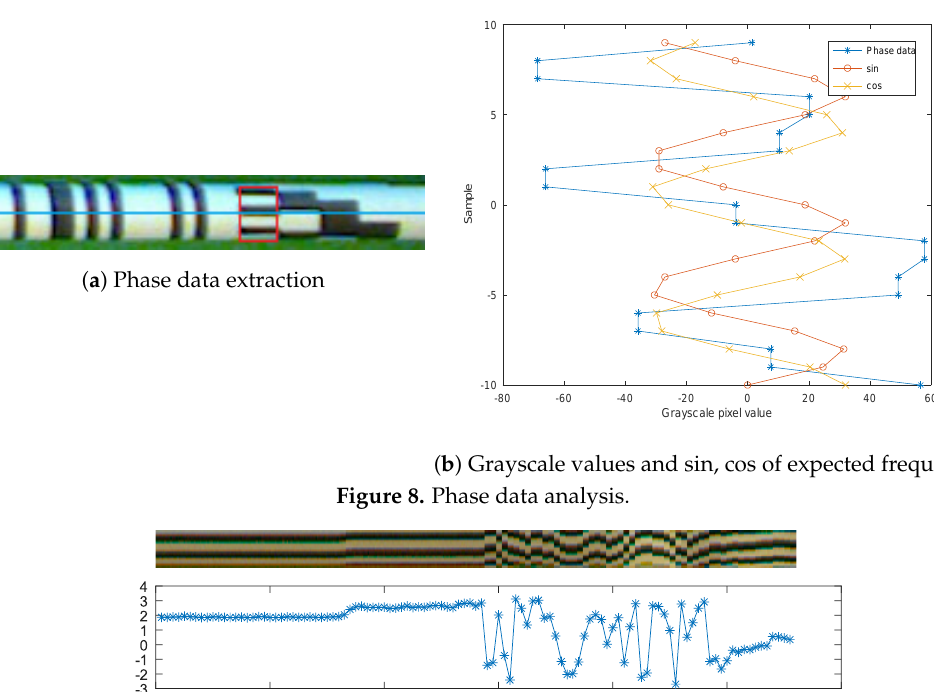
Figure 9. Phase data extracted over time ( top ) with decoded phase value in radian ( bottom